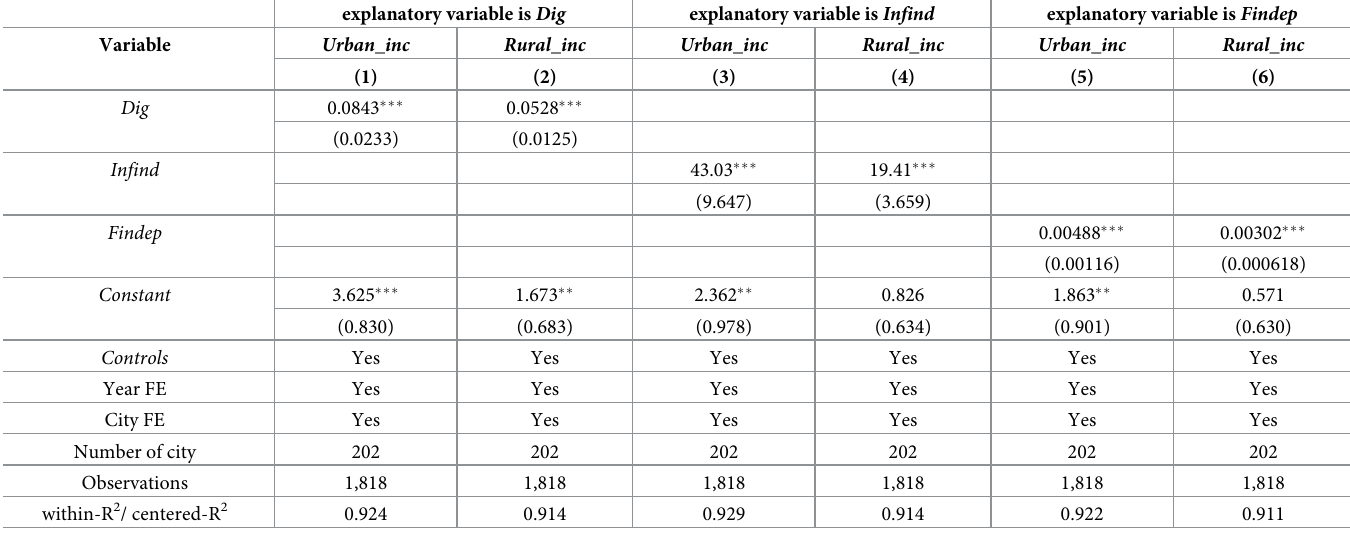
Table 5. A direct examination of absolute income levels of urban and rural